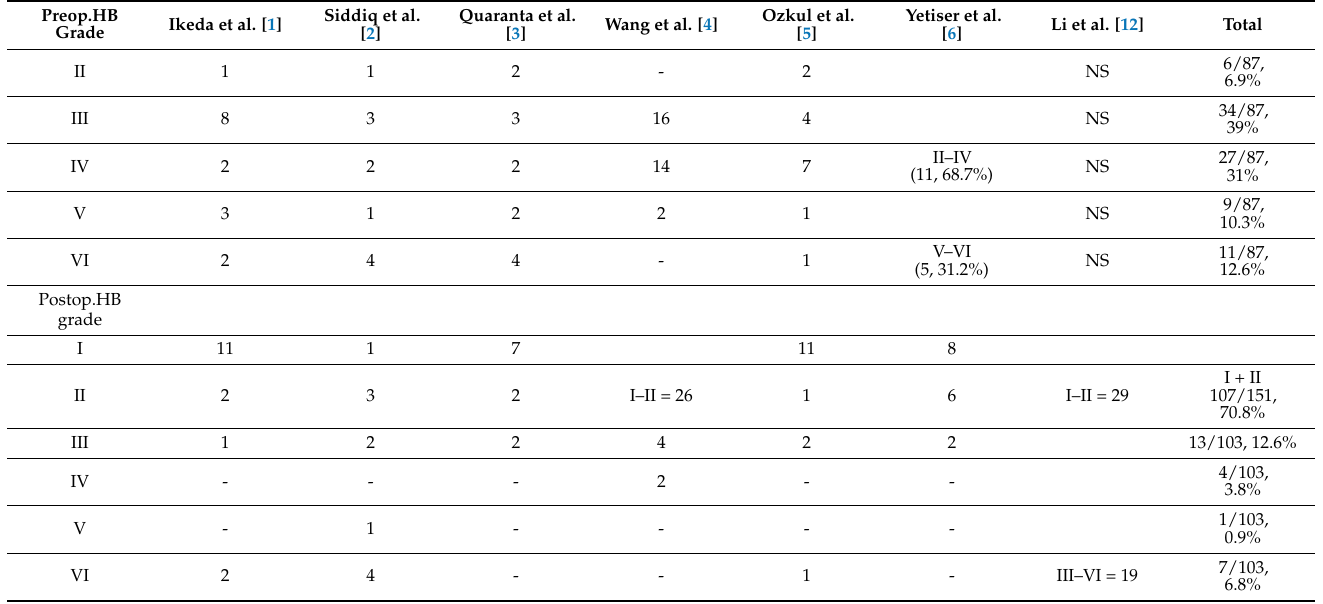
Table 3. Number of patients relating to House–Brackmann grade before and after surgery for cholesteatoma associated with facial palsy. NS: not